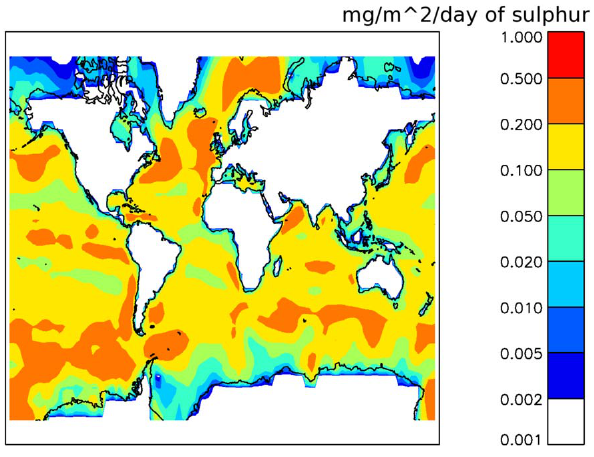
Fig. 2. The annual mean DMS flux calculated from the Kettle and Andreae (2000) climatology